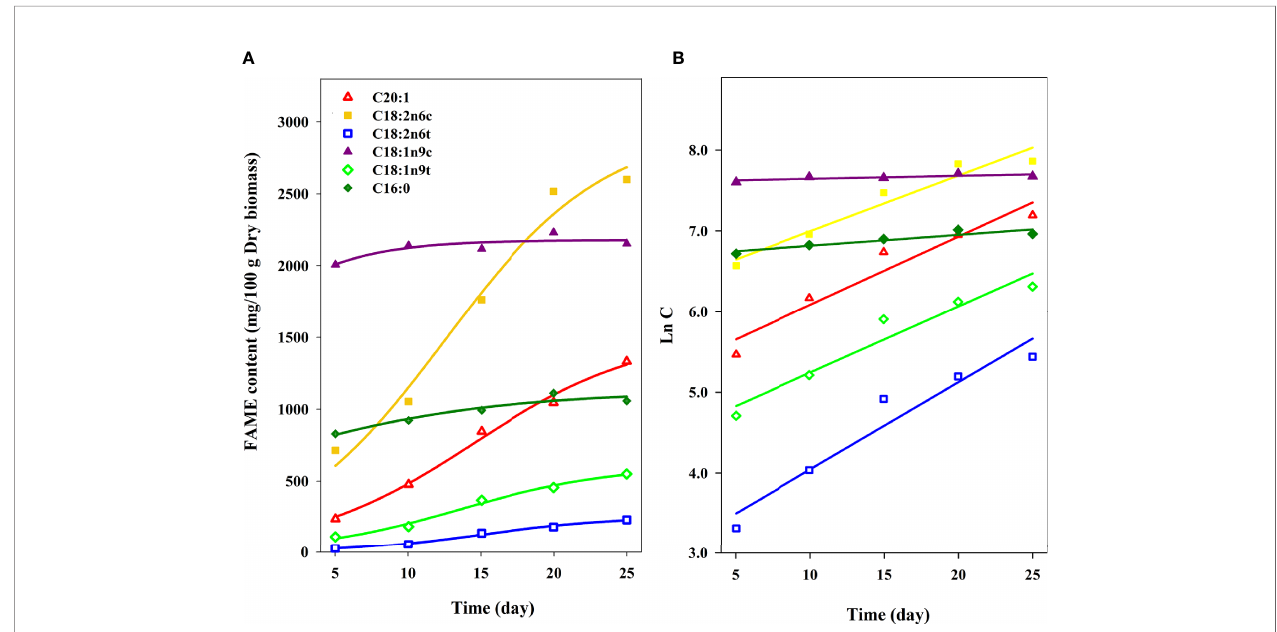
FIGURE 5 | Comparison of experimental versus predicted values of important FAME components for (A) Sigmoidal and (B) Logarithmic models. Lines represent the predicted values and symbols represent the experimental values.